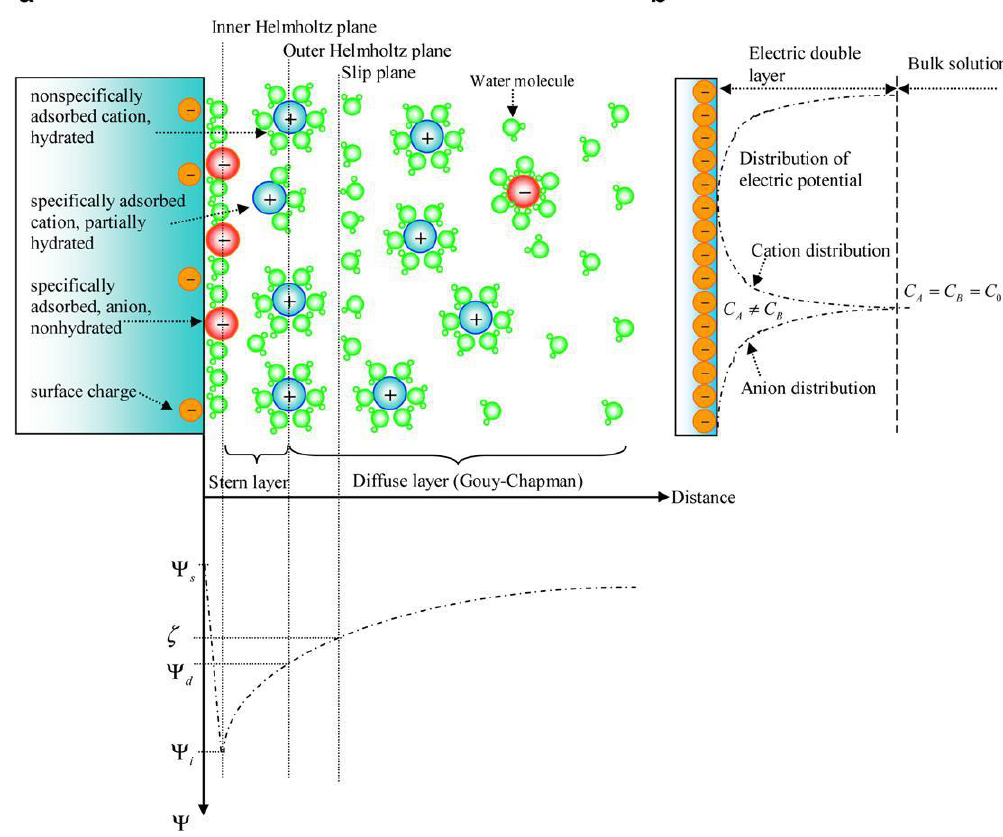
Figure 1. Schematic illustration of the ( a ) structure and ( b ) property of the electrical-double-layer in solution [6]. Reproduced from [6], with permission from Elsevier,